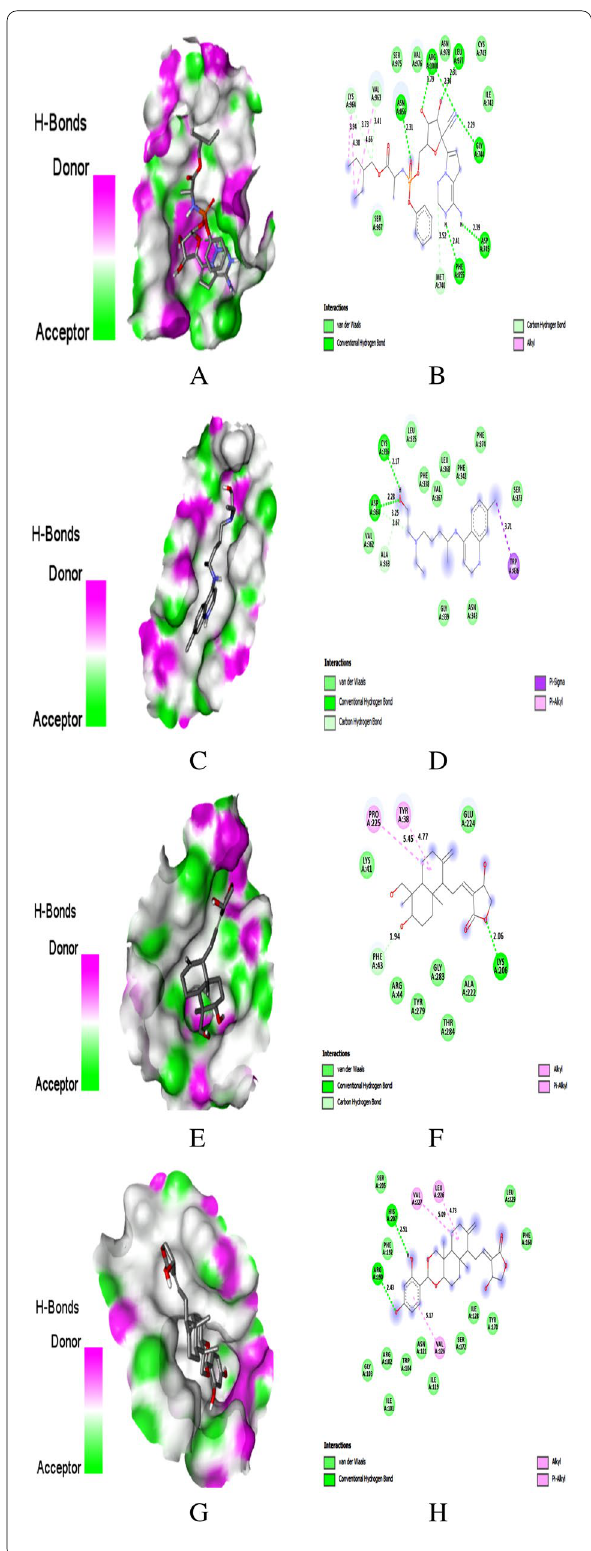
Fig. 7 Docking with spike glycoprotein. A Docking pose of REM on hydrogen bonding surface. B 2D interaction of REM. C Docking pose of HCQ on hydrogen bonding surface. D 2D interaction of HCQ. E Docking pose of AGP on hydrogen bonding surface. F 2D interaction of AGP, G Docking pose of AGP-13 on hydrogen bonding surface. H 2D interaction of